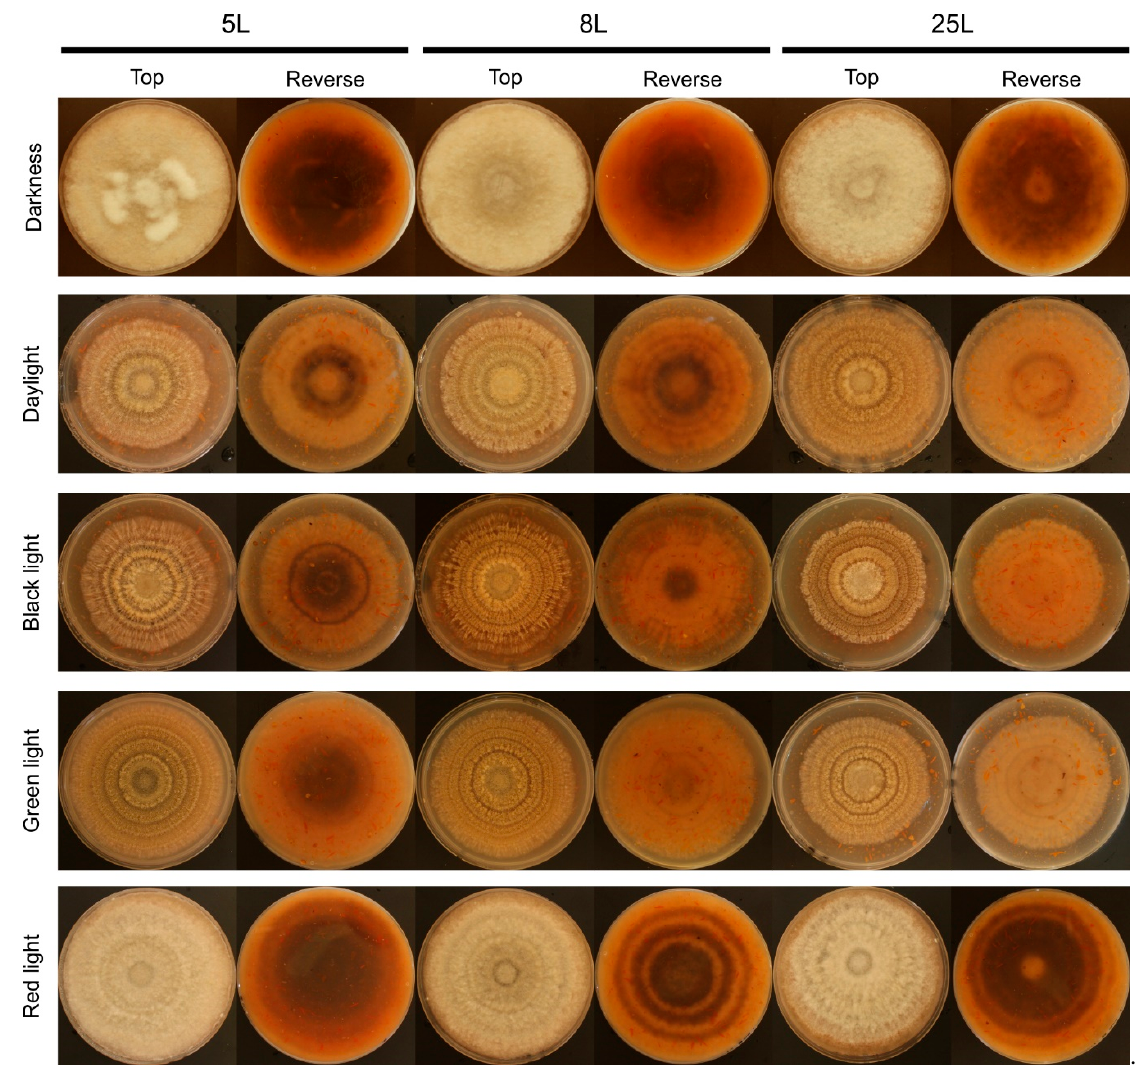
Figure 2. Effect of different light conditions on Monilinia laxa colony growth (top and reverse view) on PDA-T plates inoculated with 5L, 8L, and 25L M. laxa isolates after 7 days under continuous darkness and illuminated with daylight, black, green, and red lights for 16 h light/8 h darkness.